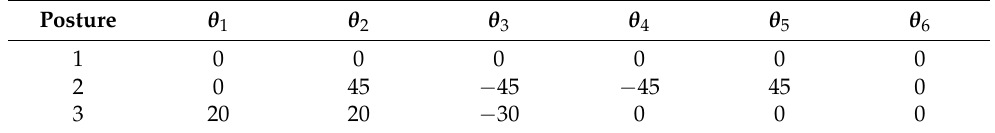
Table 6. The selected configurations ( ◦ ).